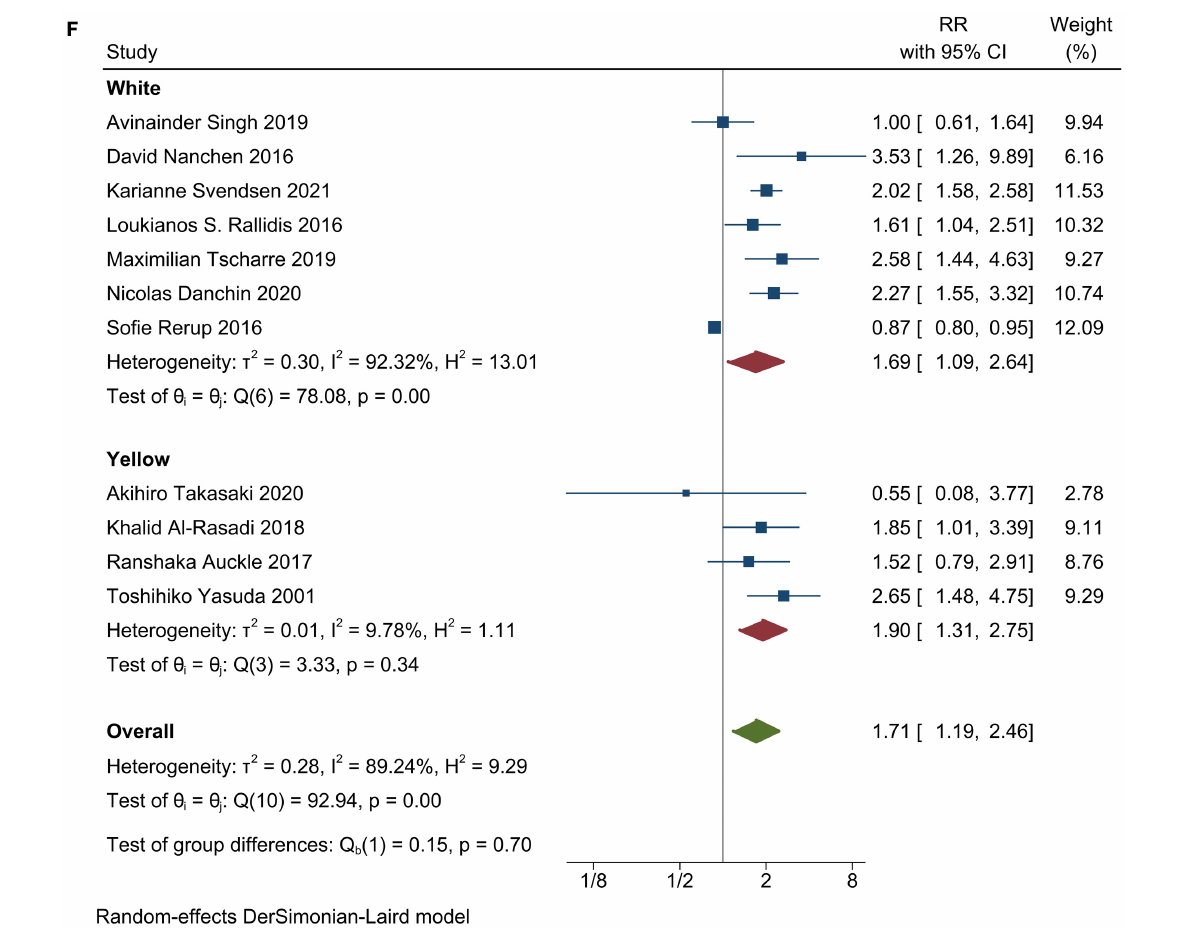
FIGURE 3 | Forest plots analysis performed in different cohorts of ACS patients with FH. (A) the overall pooled RRs of CVE and death; (B) Adjusted HR and non-adjusted RR of CVE and death. (C) RR of CVE, all-cause of death and cardiac death; (D) RR of different diagnostic criteria; (E) RR of short-time and long-time follow-up; (F) RR of Whites and